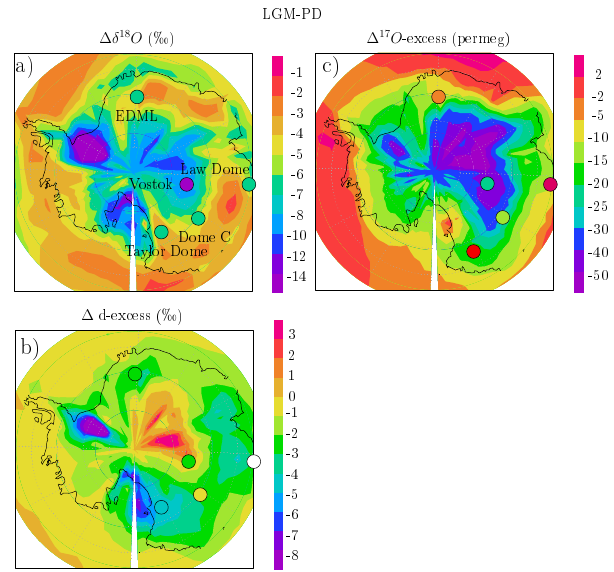
Fig. 7. LGM minus present-day difference in precipitation δ 18 O , d- excess and 17 O -excess in Antarctica observed in ice cores (colored circles) and simulated (shaded) by LMDZ over Antarctica. Numer- ical values are given in Table